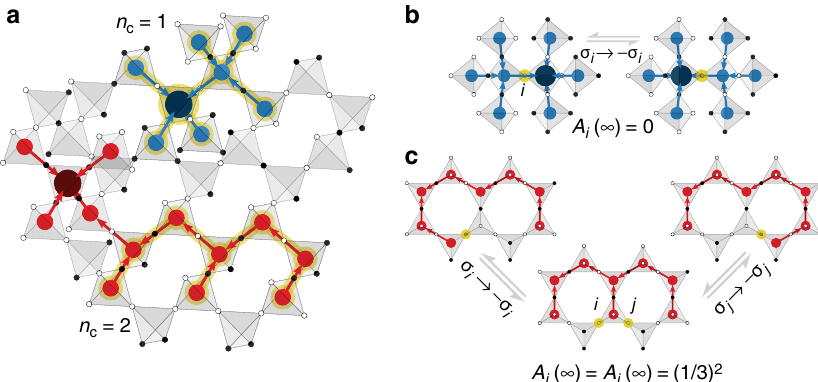
Figure 6 | Dynamical clusters in spin slush. We illustrate some of the dynamical clusters that can appear in the spin slush ground-state manifold. In ( a ) we show an example of part of a state with two such clusters, one containing a single dynamical spin ( n c ¼ 1) and the other containing two dynamical spins ( n c ¼ 2), with the dynamical spins and the surrounding charges highlighted in gold. In ( b ) we show the accessible states of an n c ¼ 1 dynamical cluster where the two states yield an average spin of zero and thus A i ( N ) ¼ 0. In ( c ) we show the n c ¼ 2 case, where one finds three accessible states with an average spin of ± 1/3 and thus A i ( N ) ¼ A j ( N ) ¼ (1/3) 2 . In ( b , c ) the flippable spins for each state are highlighted in